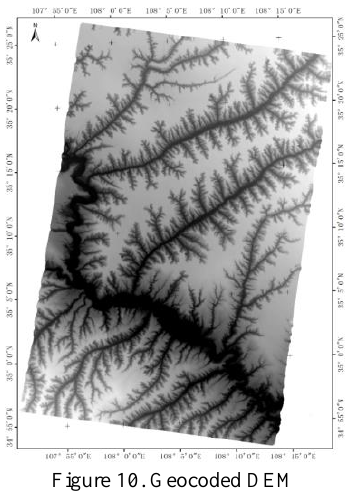
Figure 10. Geocoded DEM